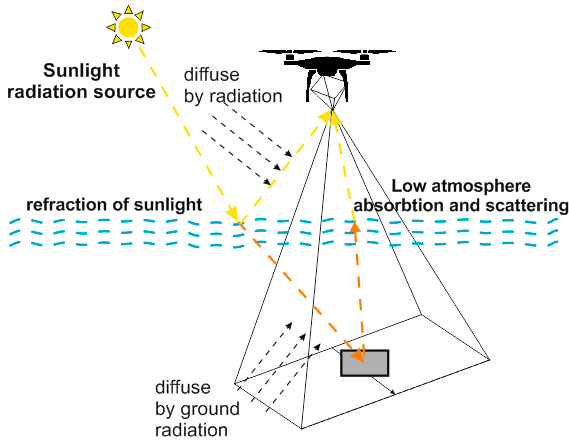
Figure 12. Scheme of low atmosphere scattering model for UAV imaging.